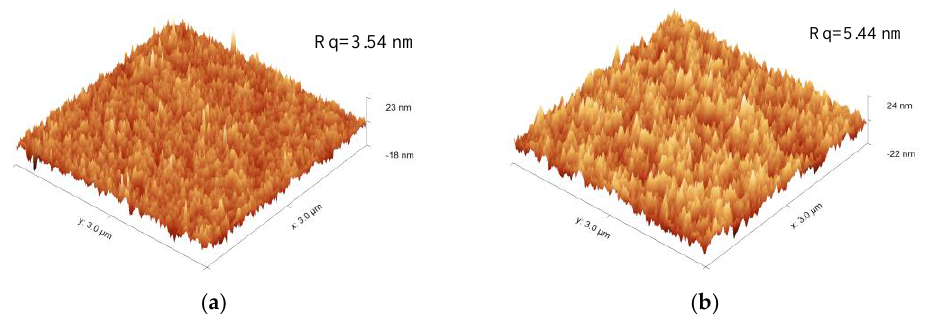
Figure 7. The surface morphologies by AFM of untreated (M/T = 0.3) film ( a ) and the film after treatment ( b ).